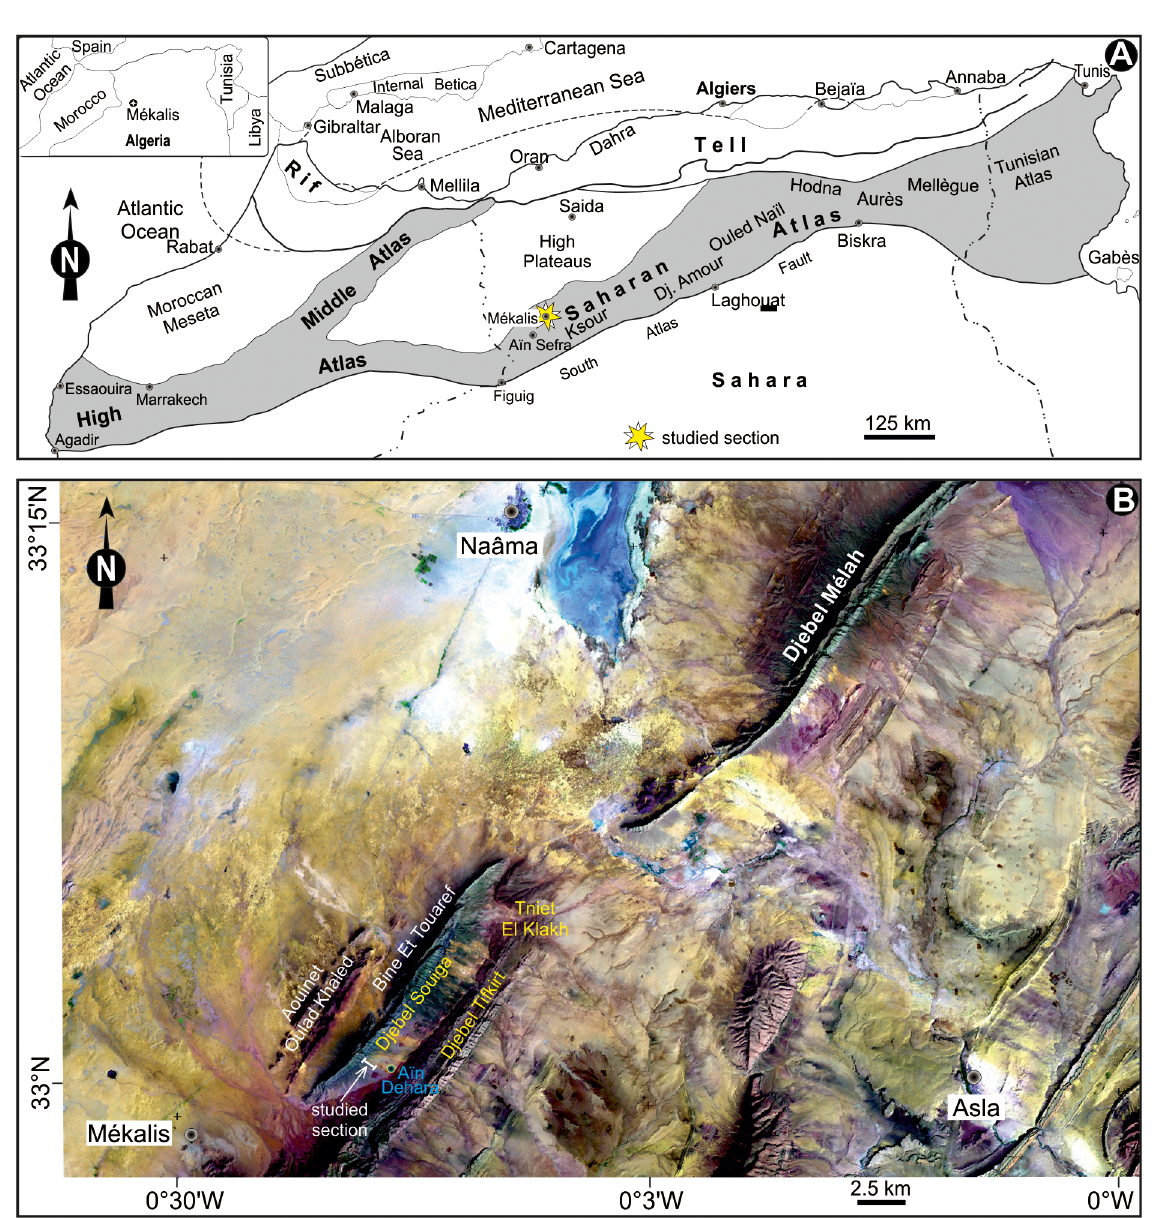
Fig. 1. A , position of the studied section; B , satellite image showing the studied